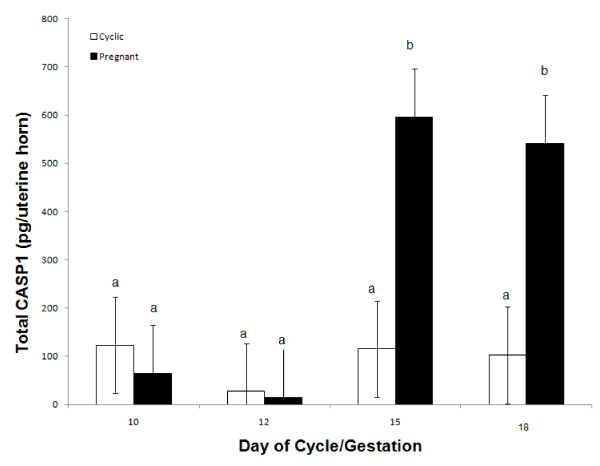
In situ hybridization analysis of caspase-1 mRNA expression in porcine endometrium. Protected transcripts in endometrium from day 15 of pregnancy was visualized by liquid emulsion autoradiography and imaged under bright-field and dark-field illumination. Endometrial sections from E treated section on Day 12 of pregnancy was hybridized with radiolabeled sense cRNA probe to serve as a negative control. Caspase-1 mRNA expression is abundant in the luminal (L) and glandular (G) epithelium but low to absent in the stroma (S). 4× Objective and 10× eyepiece.